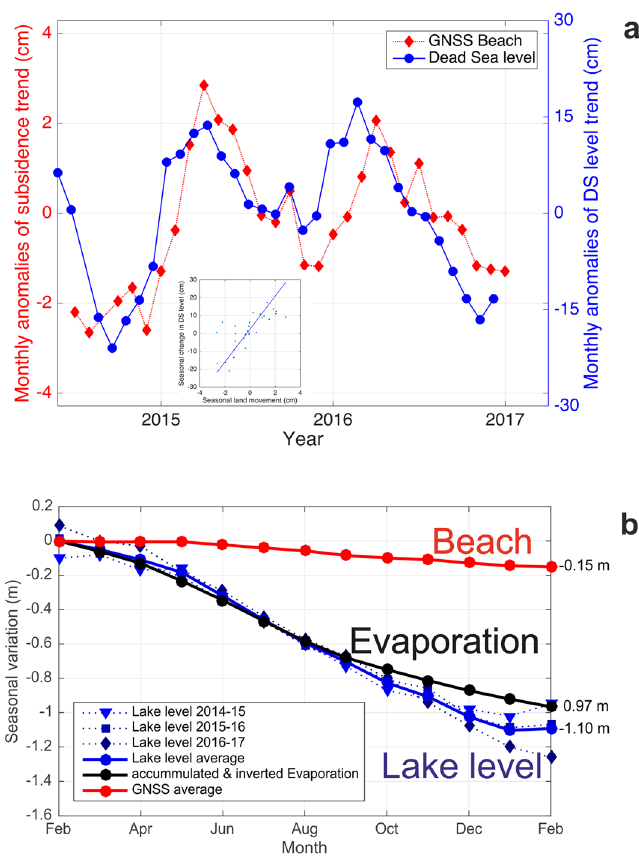
Figure 4. ( a ) Monthly anomalies of the subsidence of the Beach station (red, from GNSS) and of the drop of the lake level of the DS (blue, gauge) from June 2014 to March 2017, after removal of their respective 3-year trends (− 15.3 cm/year and − 110 cm/year). The standard error for the subsidence anomalies is ± 1.1 cm and for the lake level anomalies is ± 2.7 cm. (Insert) Correlation between the two time series after backward shifting of the subsidence time series by 2 months, with a correlation coefficient of 0.84 (see also Supplementary Fig. S_3). ( b ) Absolute values for Beach subsidence (red), lake level drop (blue) and evaporation (black), respectively, for three 12-month periods from February to February (2014/2015, 2015/2016, 2016/2017). The solid lines depict the respective average over the three years; the dashed lines are the values for the single years. The winter 2014/2015 was wet (see Supplementary Fig. S_6) and that of 2016/2017 was dry, both visible in higher or lower lake level values, respectively. The values for the cumulative evaporation are based on Ref. 10 . The scaling factor between Beach (land) and the DS lake level is 7.2; i.e. − 100 cm DS lake level decrease corresponds to − 13.9 cm sinking of the